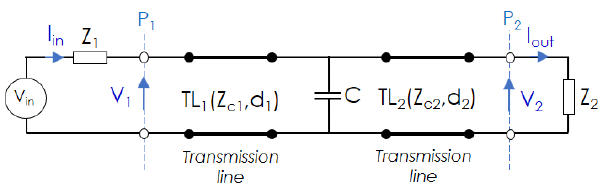
Figure 6: Considered application circuit. Table 3 addresses the parameters of the proof-of-concept